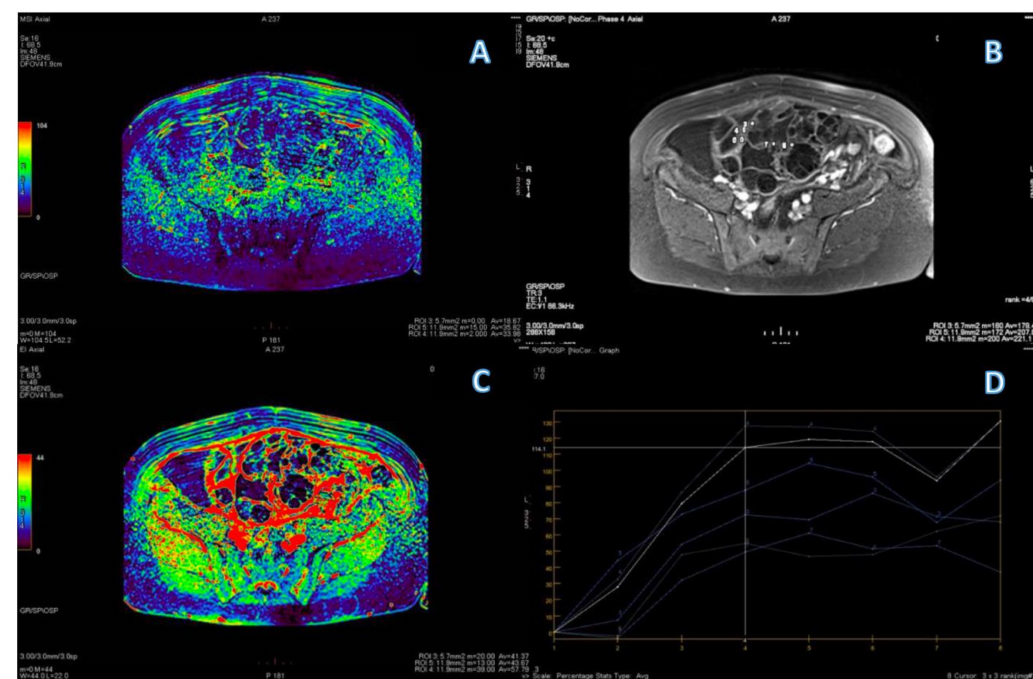
Figure 8. Images from the same 58-year-old woman with LGSC. Dynamic contrast enhancement shows dilated intratumoral vessels end-on manifesting as bright dots ( A – C ). Contrast enhancement curves ( D ).